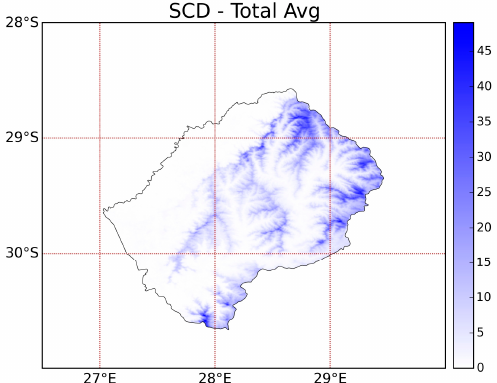
Figure 7. Snow covered days (averaged from data between 2000 and 2014). The dark blue colors represent areas with an average snow cover duration of more than 40 days, which coincides with the highest elevations in Lesotho. In contrast, the lowlands (valleys) are covered by snow for only five days or less (light blue colors).